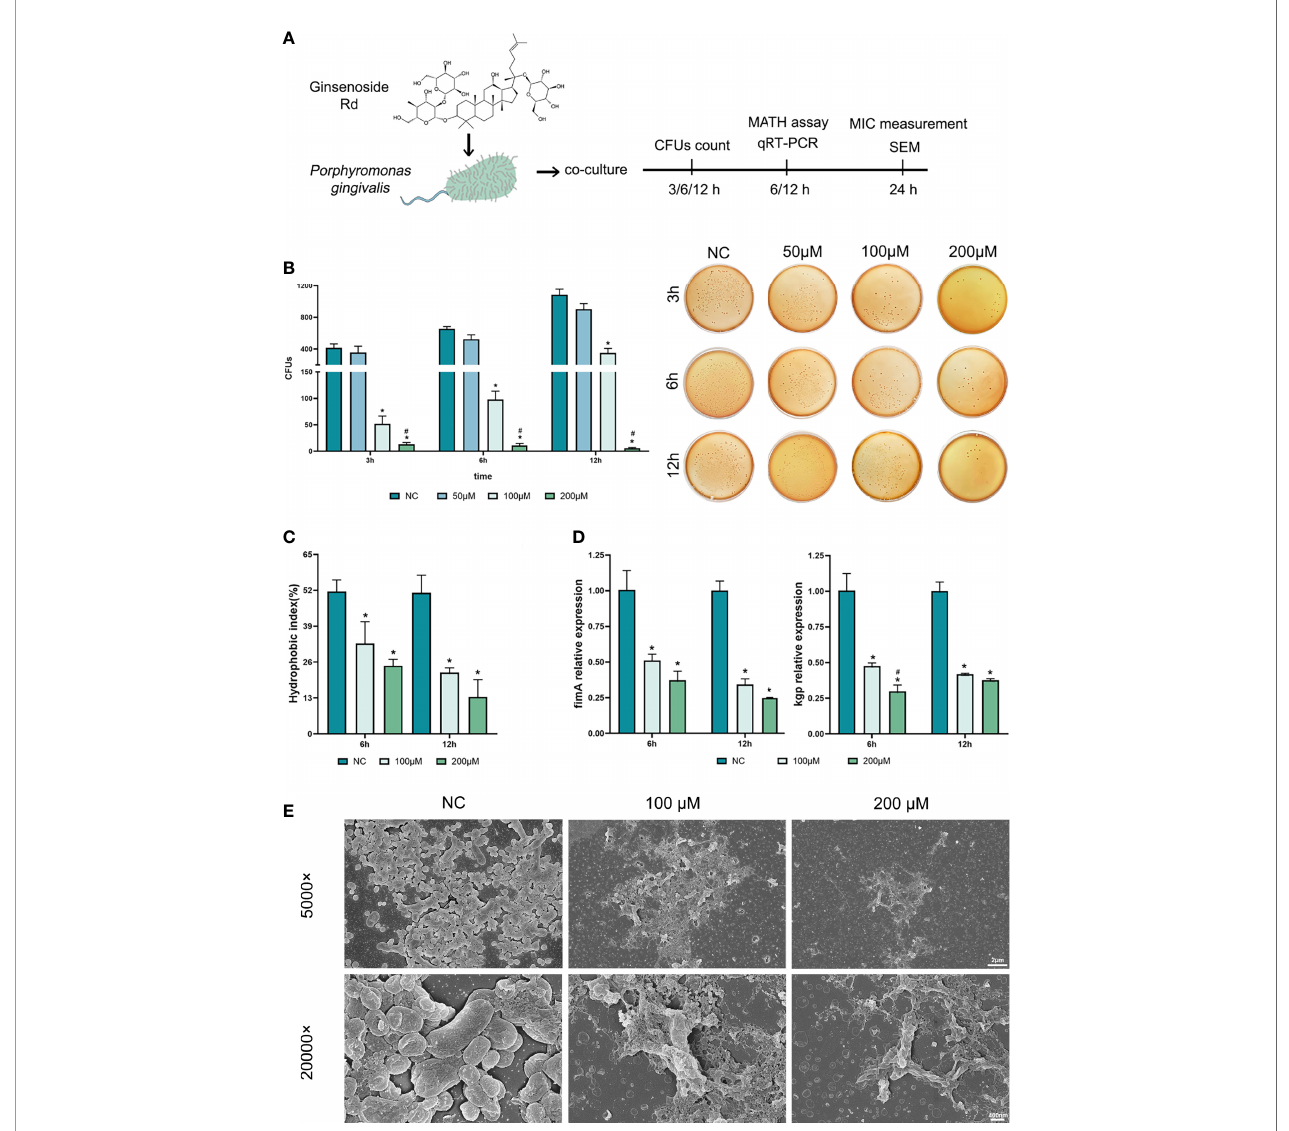
FIGURE 1 | Antibacterial effects of ginsenoside Rd towards planktonic P. gingivalis . (A) The sketch of antibacteria experiments. (B) Short-term effects on P. gingivalis and representative photographs of agar plates were displayed. (C) The hydrophobic indexes of P. gingivalis . (D) Expressions of kgp and fi mA genes were normalized by the 2 − DD Ct method relative to the P. gingivalis 16s rRNA gene. The results are shown as mean ± SD ( n = 3). * p < 0.05 versus the normal control; # p < 0.05 versus the 100- m M group. (E) SEM images showed the population and morphology of P. gingivalis at magni fi cations of ×5,000 and